Question: Provide a one-line summary of what is displayed.
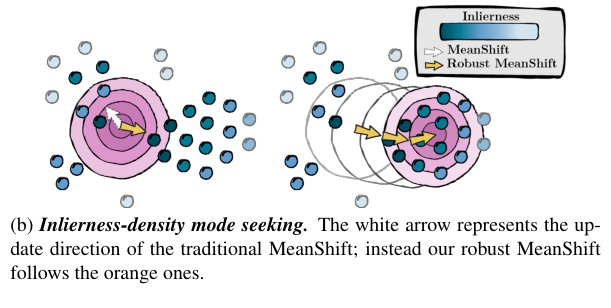
Answer: Interpretation of Eqs. (6) and (8) in (a) and (b) respec- tively. Our robust MeanShift alternatively solves these 2 equations until convergence. A pseudocode is available in Appendix C.